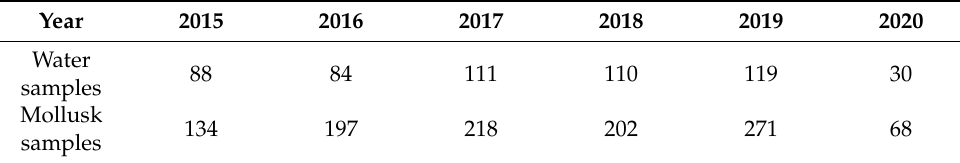
Table 2. Number of total water and mollusk samples analyzed from 2015 to March